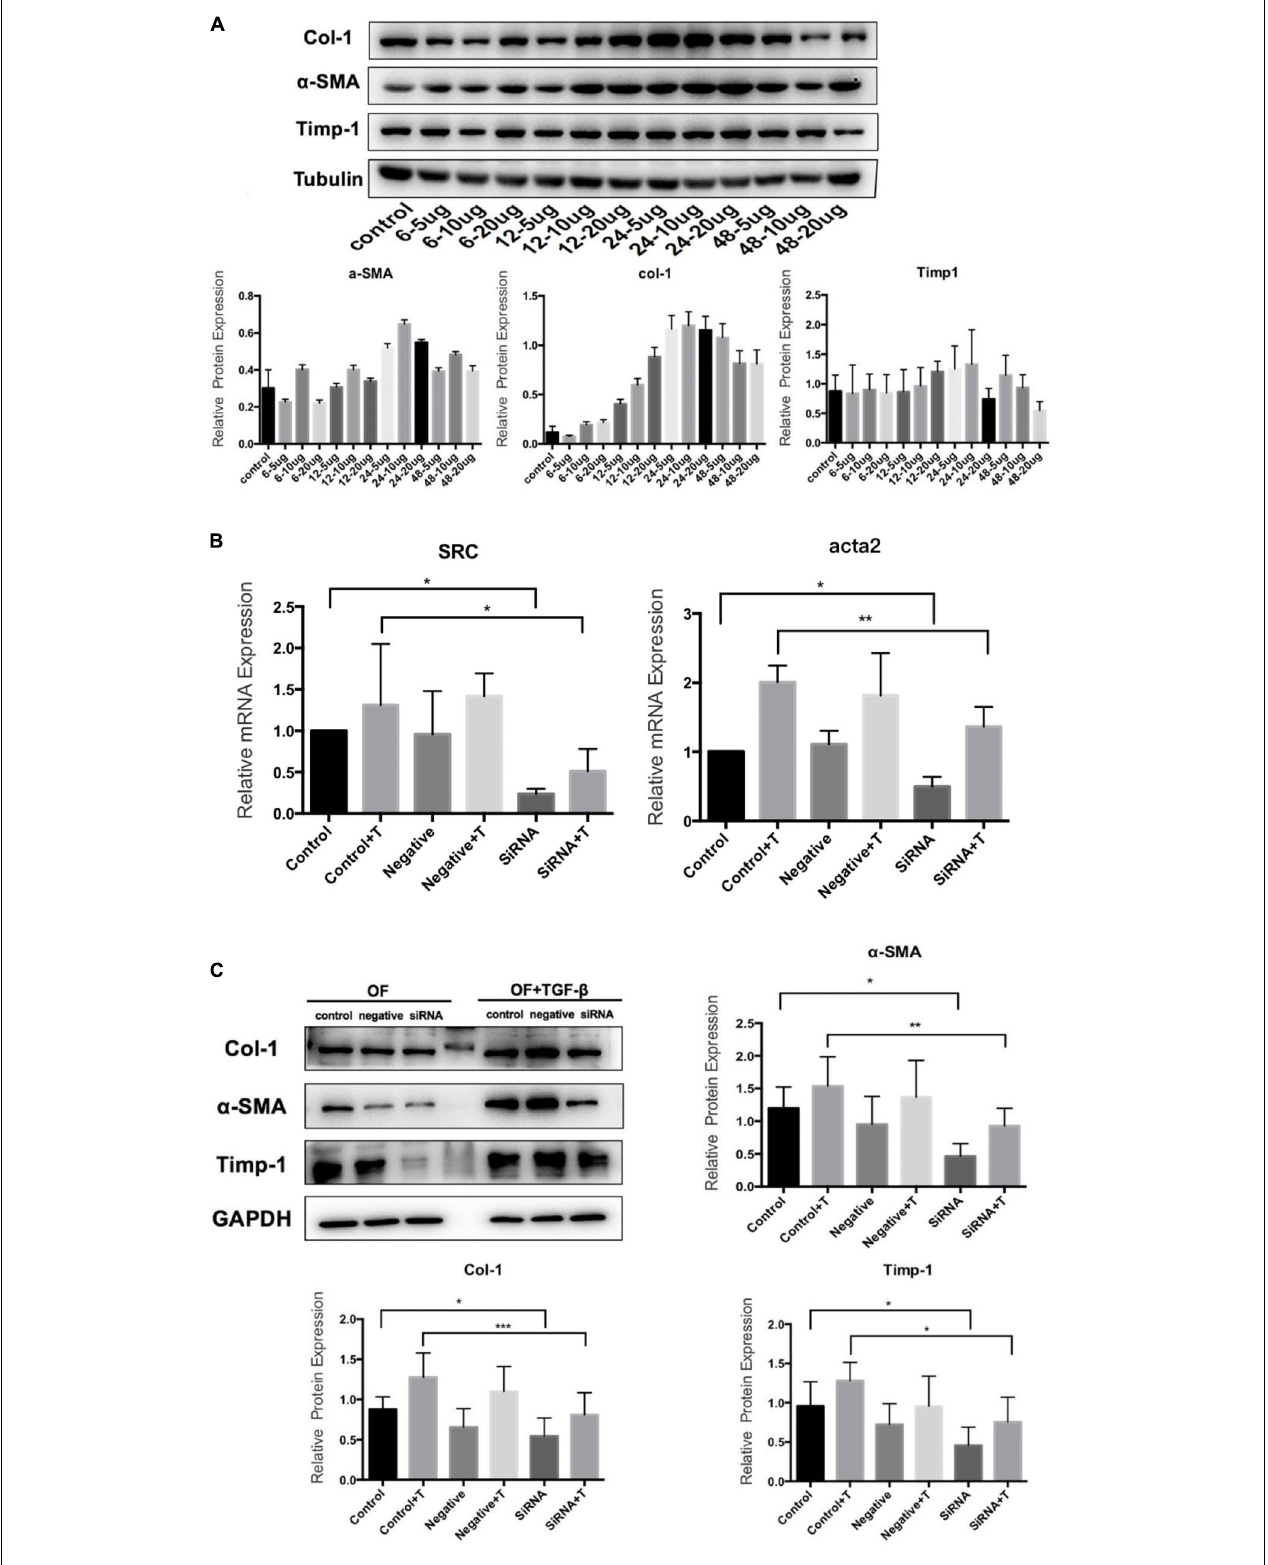
FIGURE 7 | TGF- β 1 induces the transformation from OF to MFB. (A) Western blot for TGF- β 1 concentration and time; (B) Src and Acta2 expression in SRC gene knockdown group by q-PCR; and (C) the expression levels of α -SMA, Col-1, and Timp-1 in the SRC gene knockdown group by Western blot.